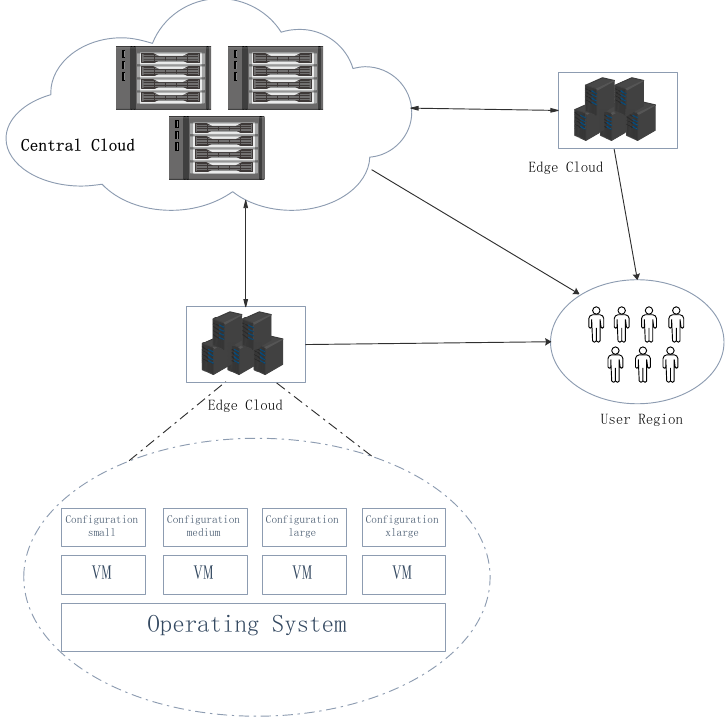
Figure 2. Task offloading and resource allocation in the MEC cloud